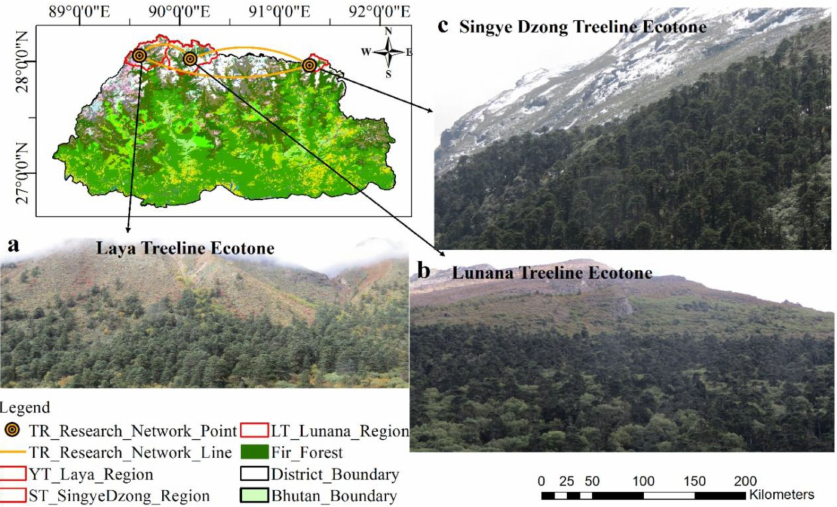
Figure 1. Tree-ring research network sites and treeline ecotones at high elevation mountains of Northern Bhutan. A map shows three specific treeline research sites (golden concentric circles) and three treeline regions (Lunana, Laya, and Singye Dzong—pink polygons) connected by golden thick curved lines. Sampling treeline ecotones of three regions (( a ) Laya and ( b ) Lunana and ( c ) Singye Dzong) are ground pictorial presentation. Land use types shaded by various colours—fir forest by dark green, and glacier/snow covers by white. The Figure was generated using ArcGIS10.8 and data from MOAF, and NLC and GPS and field photos from field